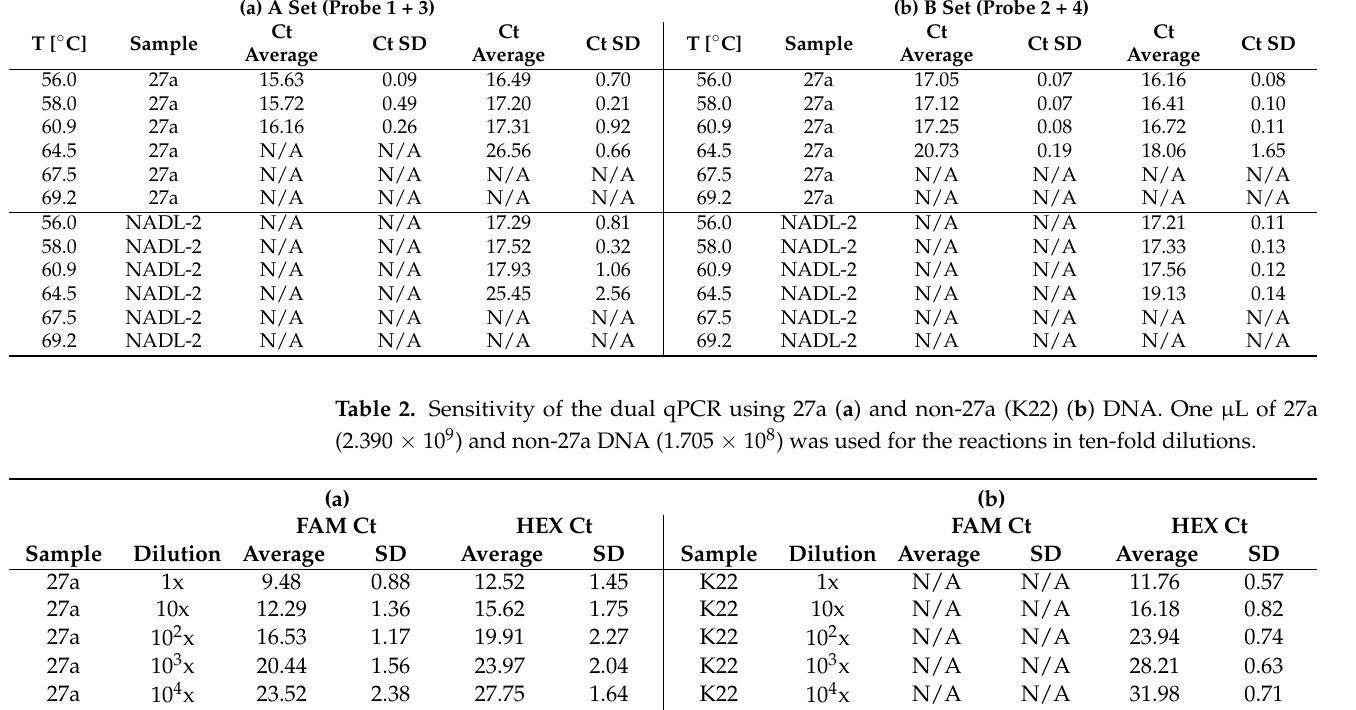
Comparing the detection limit of the 27a dual PCRs (<1.66 × 10 4 copy/reaction in the dual PCR versus < 240 copy/reaction of the dual qPCR), around a 2 order of magnitude improvement was identified. Table 1. Gradient dual qPCRs using FAM and HEX labelled probes for 27a and PPV-specific detection. In the table, the actual annealing temperatures of the gradient are shown with the corresponding Ct values. The quantity of the 27a and non-27a (NADL-2) DNA were arbitrary chosen, but the same amounts were used for each kind of reaction. FAM and HEX channels represent 27a and PPV-specific PCRs, respectively.